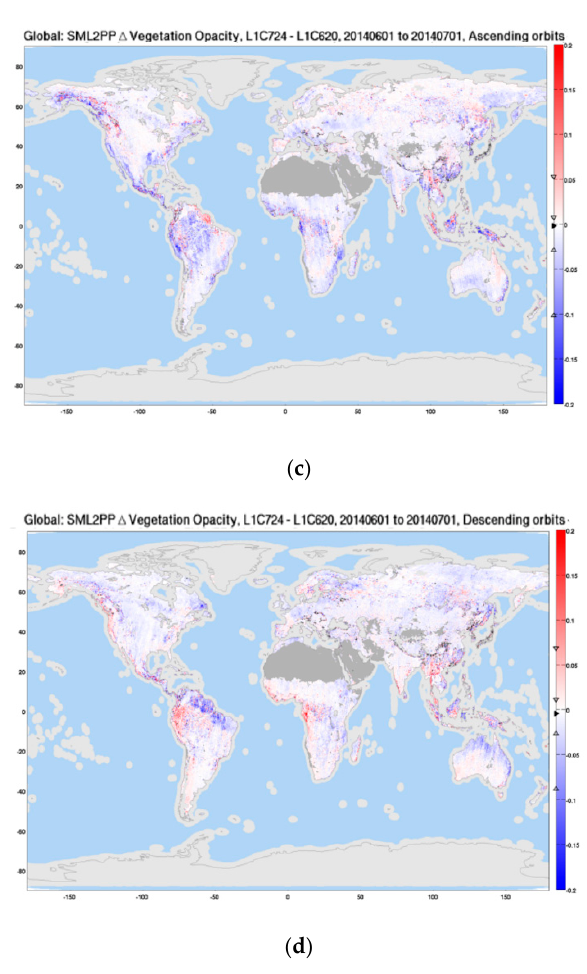
Figure 19. Maps of averaged difference, v724–v620, over the month of June 2014 in ( a ) soil moisture for ascending orbits, ( b ) soil moisture in descending orbits, ( c ) VOD in ascending orbits and ( d ) VOD in descending orbitsBlue (resp., red) indicates a decrease (resp., an increase) in V724 soil moisture, VOD compared to v620.